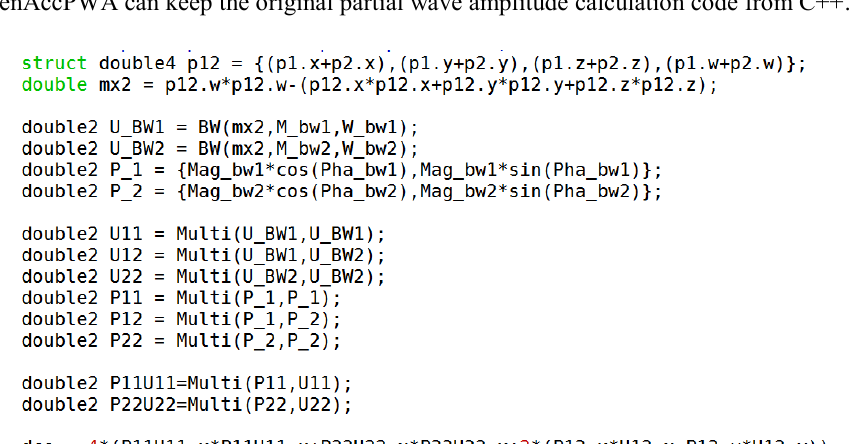
Fig. 3. Two partial wave amplitudes from the decay channel: 𝐽 𝜓⁄ → 𝛾𝐾 + 𝐾 − as OpenAccPWA code